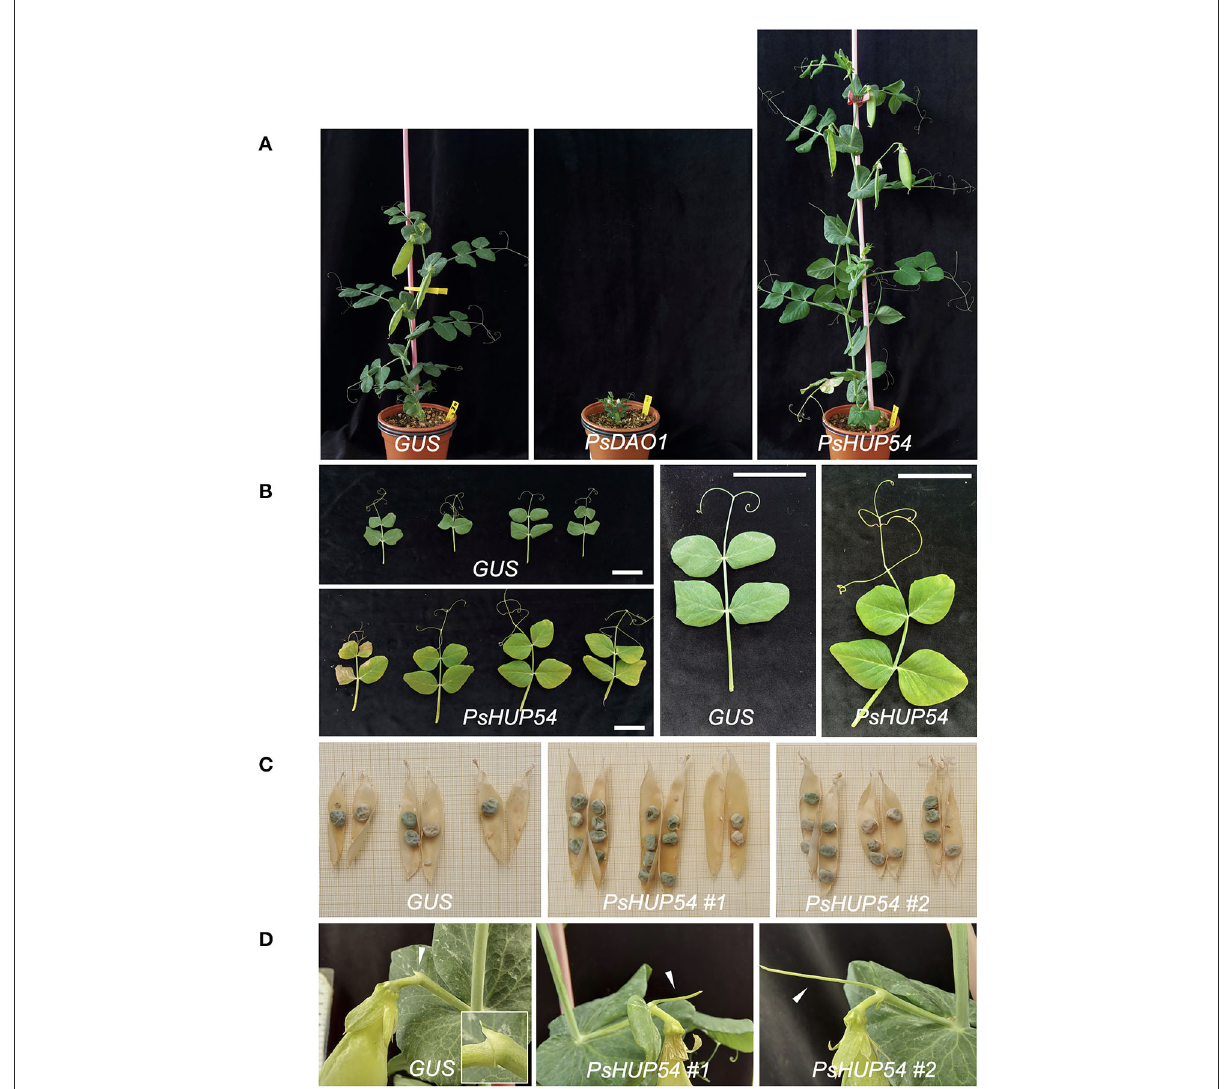
FIGURE7 Phenotype of pea VIGS plants for genes PsDAO and PsHUP54 . ( A) Representative 10-week-old GUS - VIGS (control), PsDAO1 -VIGS, and PsHUP54 -VIGS plants. (B) Leaf defects of PsHUP54 -VIGS. Leaves were sampled from the fourth node of different plants. PsHUP54 -VIGS leaves are bigger and slightly lighter than GUS -VIGS leaves. (C) Seed number and pod defects of PsHUP54 -VIGS plants. The images show the three first pods of different plants. (D) Increased stub length in PsHUP54 -VIGS plants. Stubs are marked with arrowheads. Detail of the stub in a control GUS -VIGS plant is shown in a close-up. Scale bars: